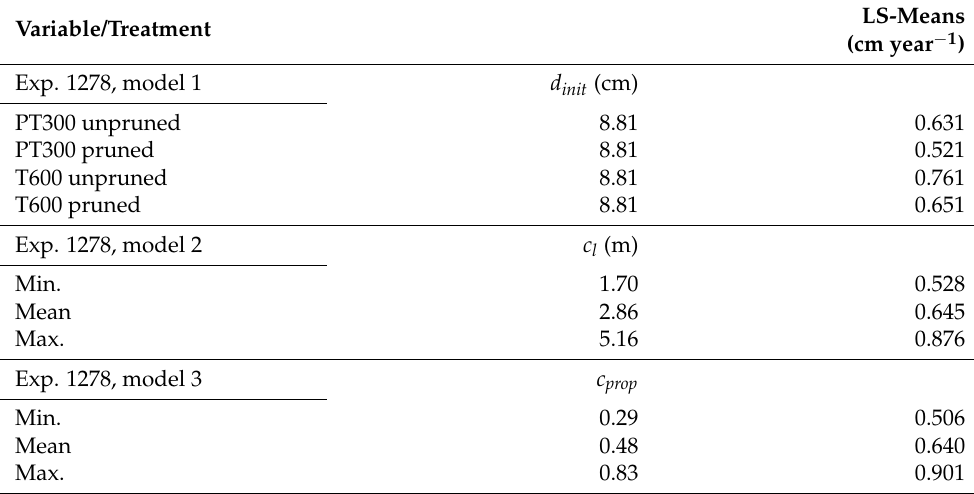
Table 8. LS-means estimates for the final model of individual crop tree growth on dbh (cf. Table